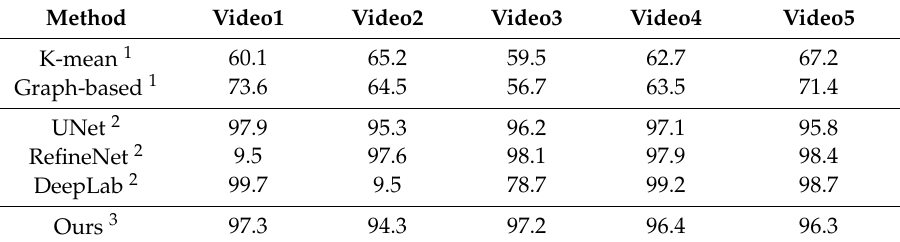
Table 2. Precision of the state-of-the-art methods and the proposed